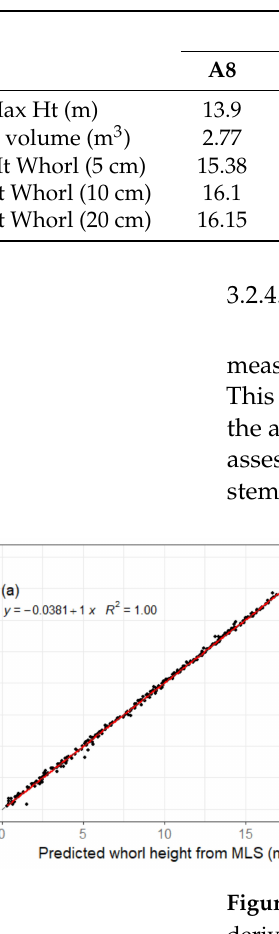
Figure 16. Relationship between field-measured volume and MLS-derived volume. The dashed line represents a 1:1 line and the red line represents a fitted linear model with linear equation and R 2 . Table 3. Tree-level volumetric calculations and whorl detection from MLS data. Results include the maximum height of stem included in the volume calculations, calculated stem volume, and the height of the highest whorl detected for 5 cm, 10 cm and 20 cm interval diameter profiles.